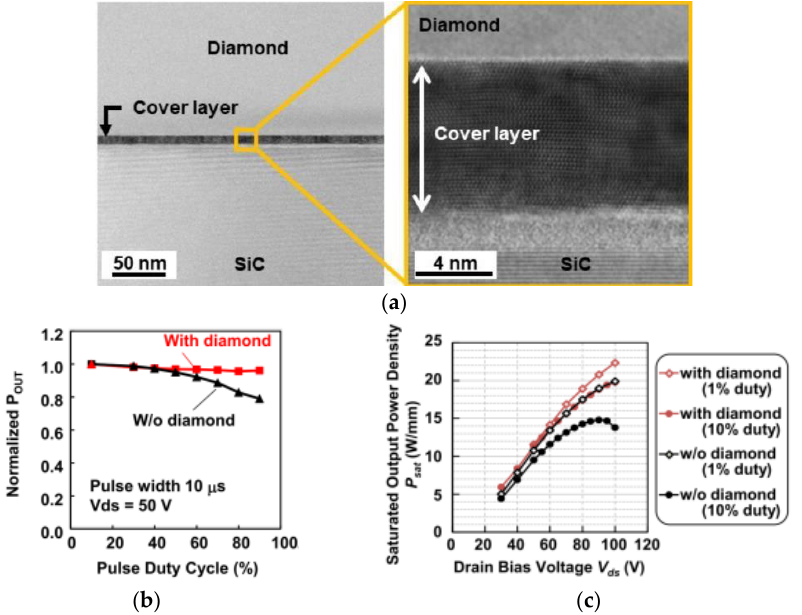
Figure 10. ( a ) Cross-section TEM image of SiC/SCD interface obtained by SAB after protecting the diamond surface with a Ti film. ( b ) Normalized P D vs. duty-cycle. ( c ) P D as a function of V D (reprinted from [118], Copyright 2020 The Japan Society of Applied Physics).